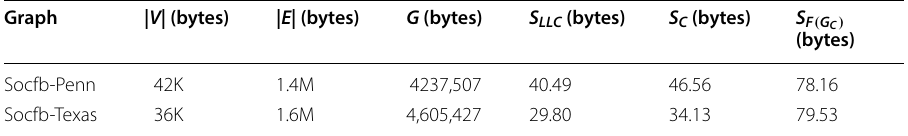
Table 3 GraphzIP Compared to bvgraph compression with layered label propagation (Llp) order